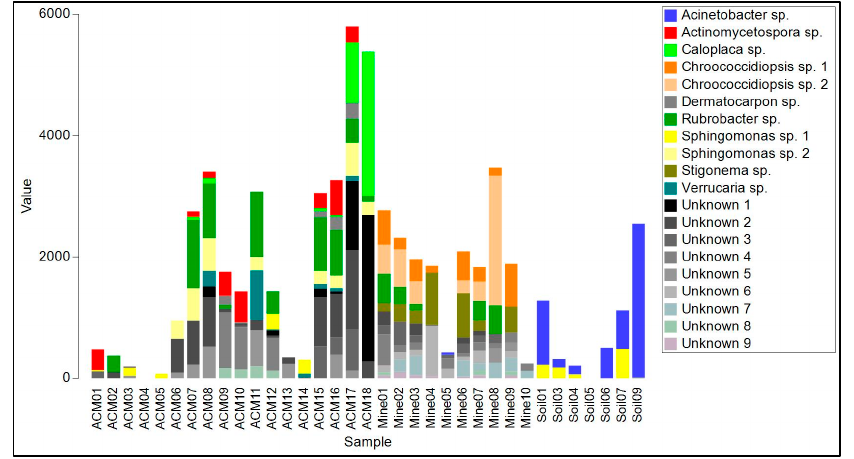
Figure 5. Read frequency of the 20 most abundant amplicon sequence variants (ASVs) from the 16S region found in each sample.